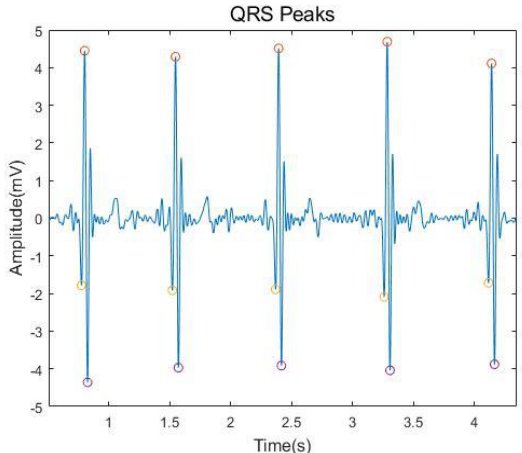
Figure 6. Detected Q, R and S peaks of an ECG signal.